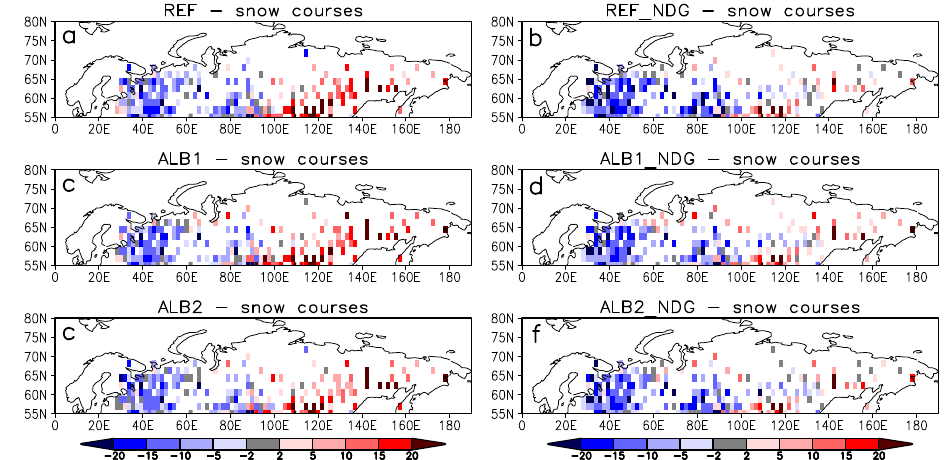
Figure 11. Differences in average snow-off date between the six ECHAM5 experiments and the Russian snow course data. Both open-terrain and forest snow courses are included in the comparison.